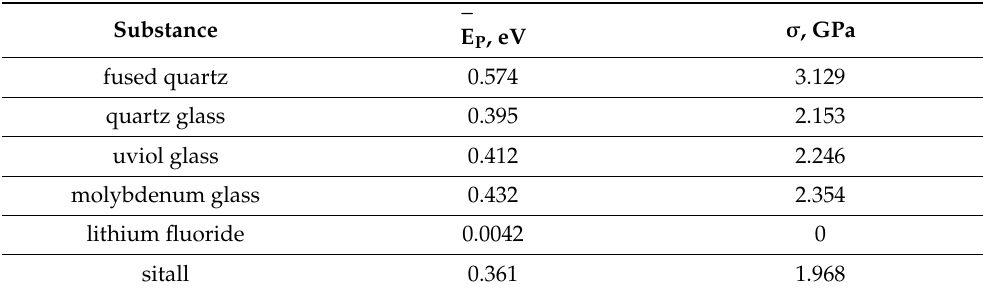
Table 6. The results of calculations of the average energies of plasmons and microstresses in glassy dielectrics, single crystal LiF and sitall. ¯ Substance E P , eV σ , GPa fused quartz 0.574 3.129 quartz glass 0.395 2.153 uviol glass 0.412 2.246 molybdenum glass 0.432 2.354 lithium fluoride 0.0042 0 sitall 0.361